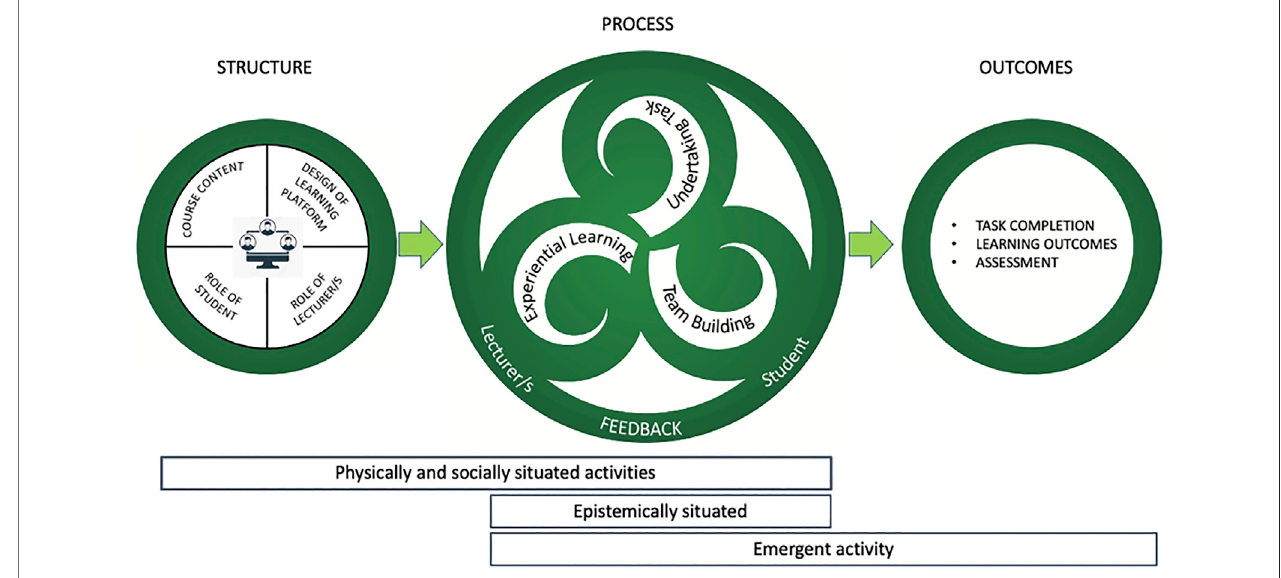
FIGURE 2 | Online learning to create spaces of belonging [adapted from Baroutsis and Mills